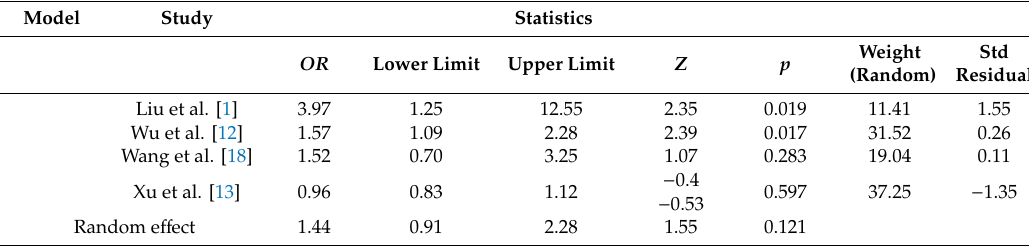
Table 4. Summary e ff ect sizes for total cholesterol (TC) serum levels and Alzheimer’s disease (AD). Model